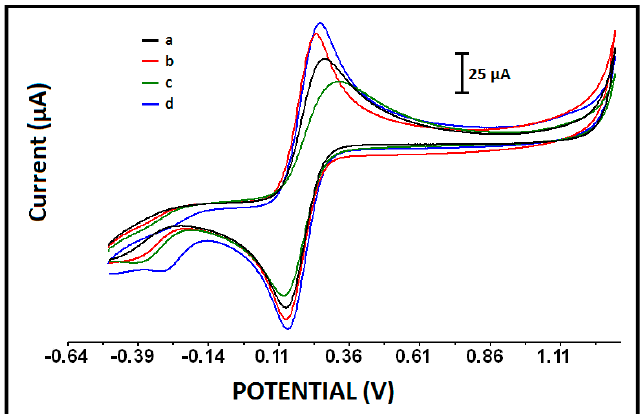
Figure 3. Cylic voltammograms of (a) PGE, (b) IL-PGE, (c) CoPc-PGE, and (d) CoPc-IL-PGE under the optimized conditions: 50 µg/mL CoPc and 5% IL modified PGE.